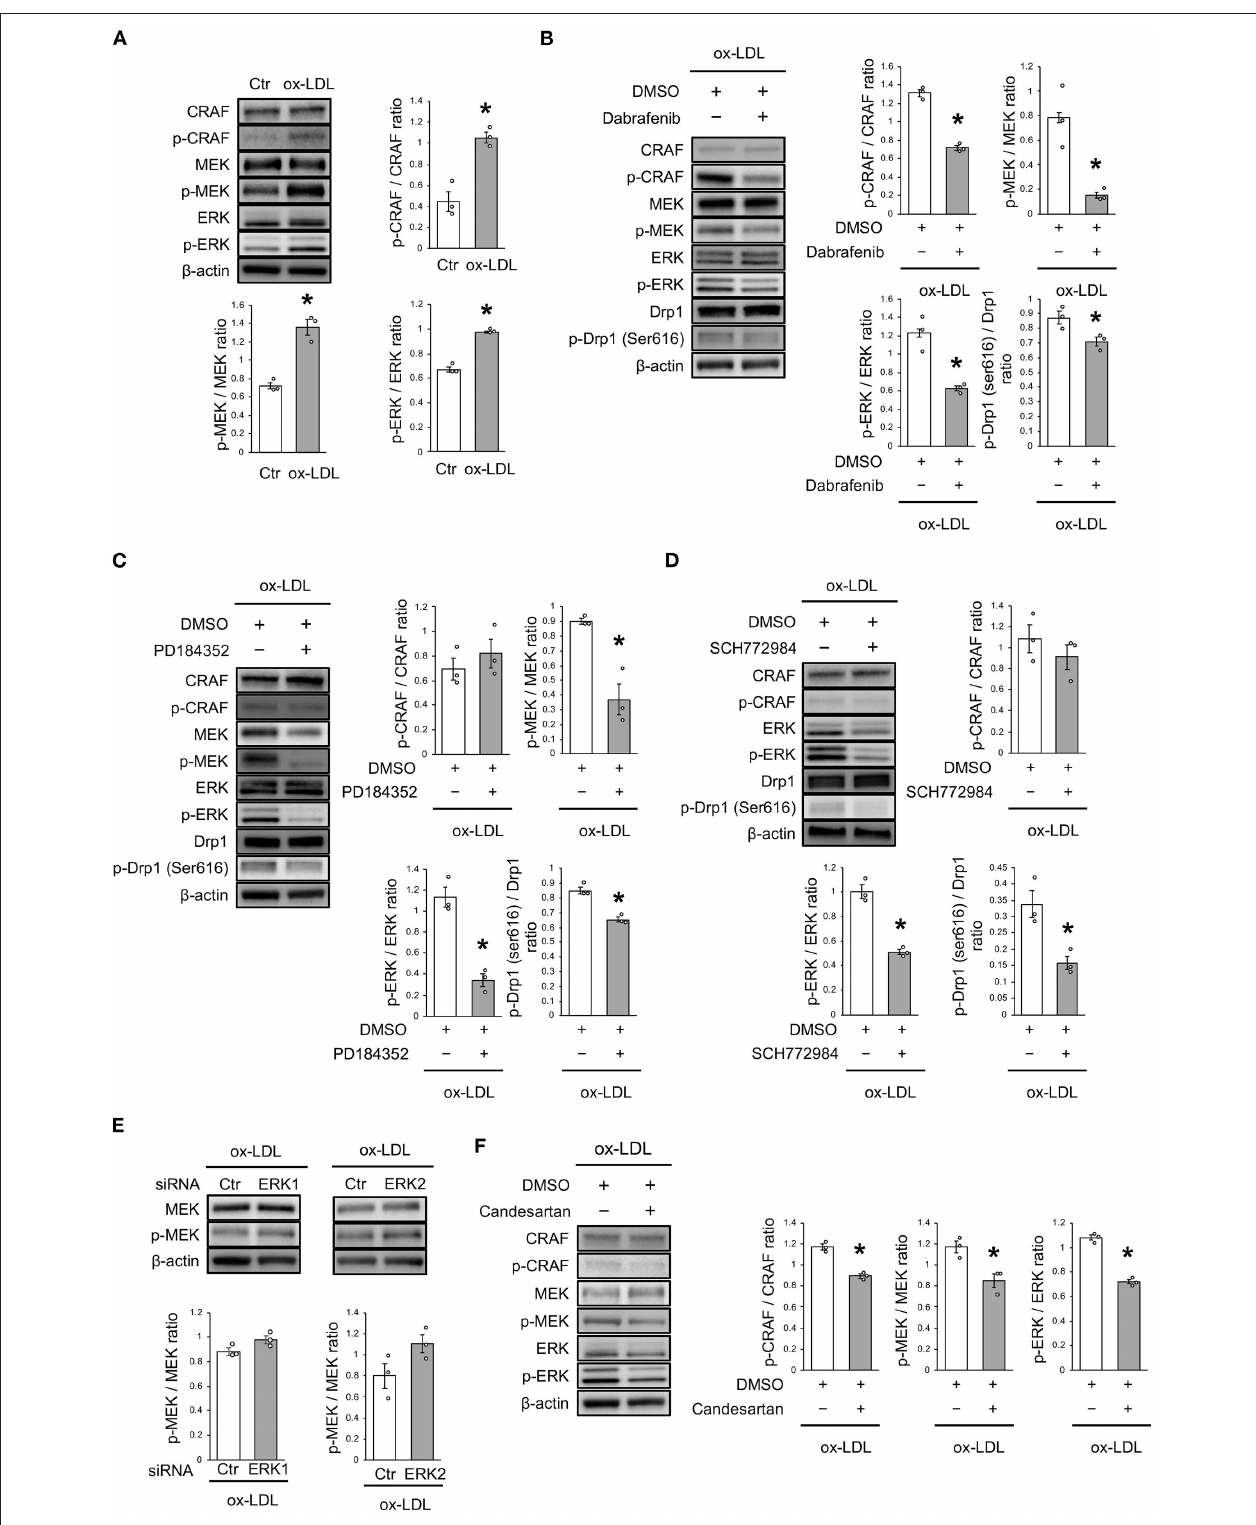
FIGURE 4 | ox-LDL induced Drp1 activation through AT1R and the CRAF/MEK/ERK pathway. (A) Immunoblots and quantitative analysis for CRAF, p-CRAF, MEK, p-MEK, ERK, p-ERK, and β -actin in cells with ox-LDL or the control. * P < 0.05 vs. the control ( n = 3 per group). (B) Immunoblots and quantitative analysis for